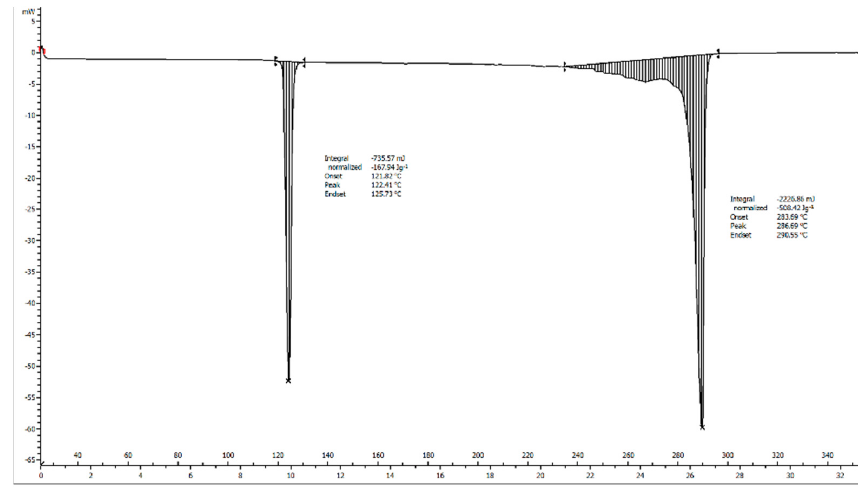
Figure A3. DSC thermogram of benzoic acid crystallized in {ethanol (1) + water (2)} ( w 1 = 0.50) mixture.